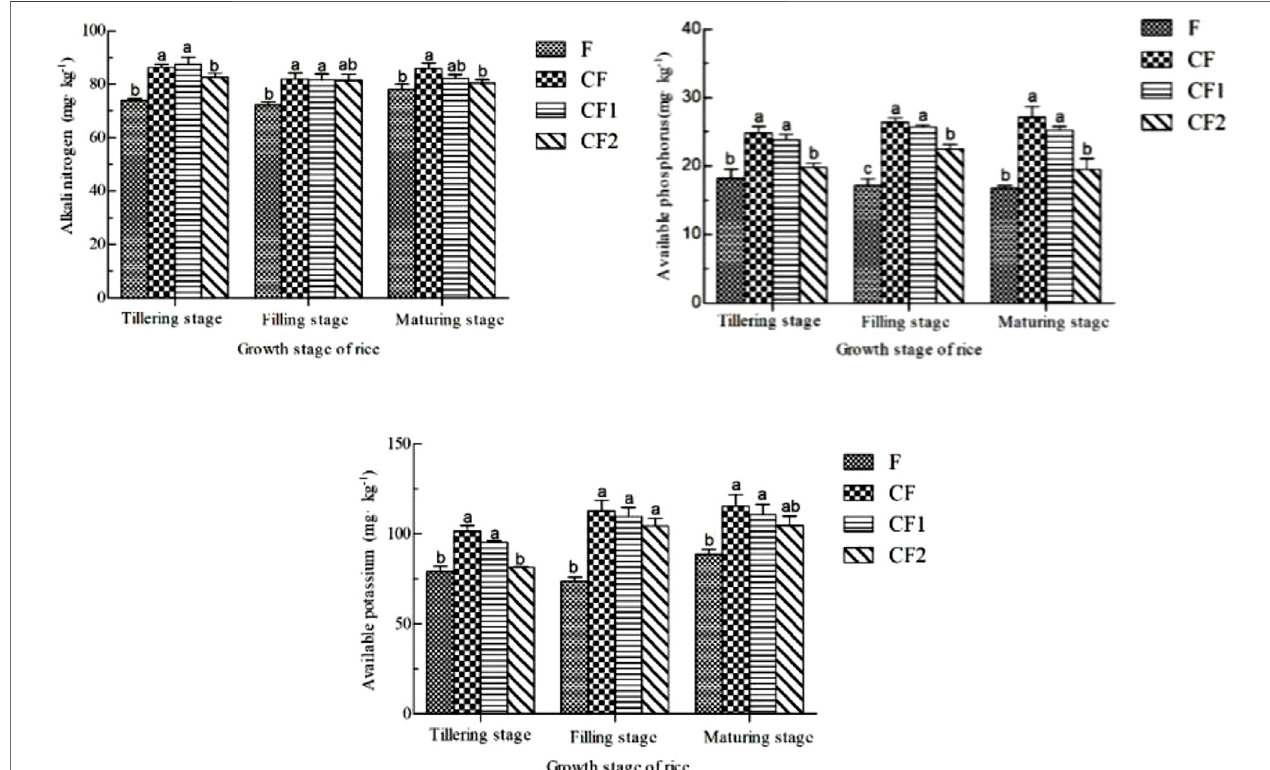
FIGURE 6 | Effect of co-application of biochar and chemical fertilizer on soil-available nutrients.